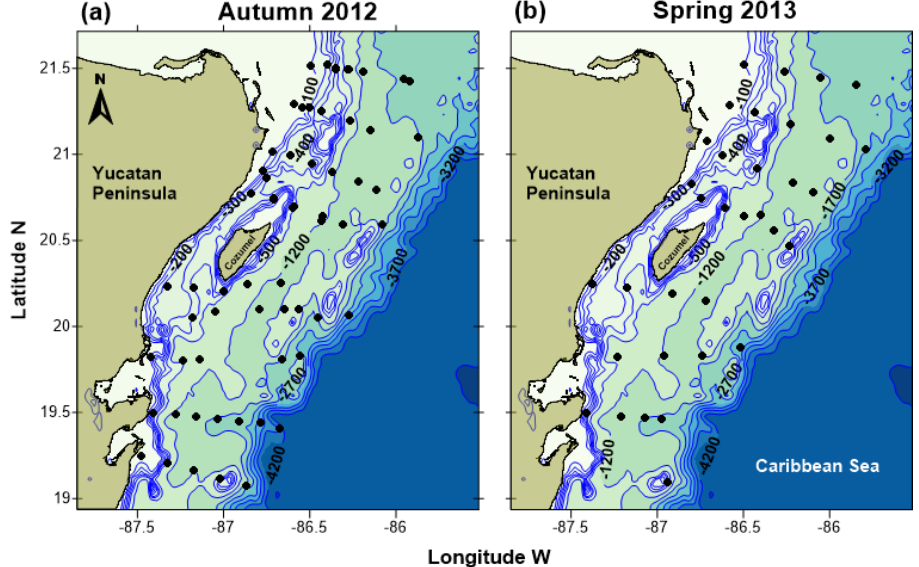
Figure 1. Study area showing location of plankton sampling stations (black dots) during ( a ) the autumn 2012 cruise and ( b ) the spring 2013 cruise.